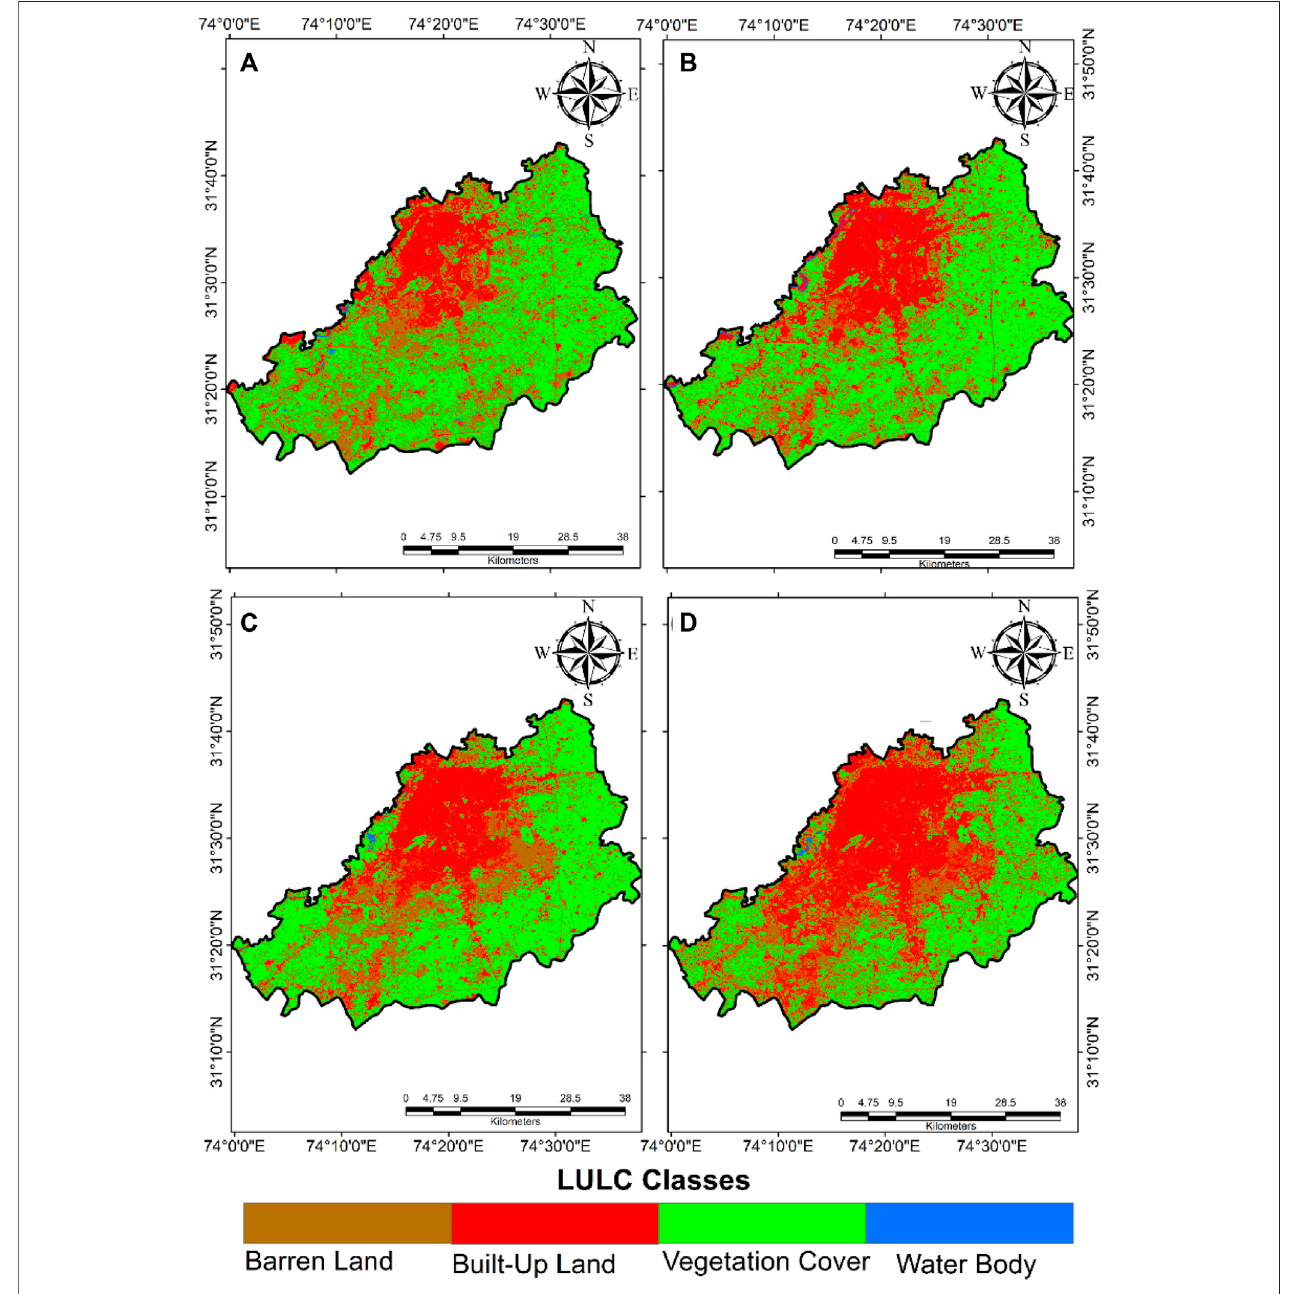
FIGURE 3 | Spatial distribution of LULC of Lahore for the years (A) 1990, (B) 2000, (C) 2010, and (D) 2020